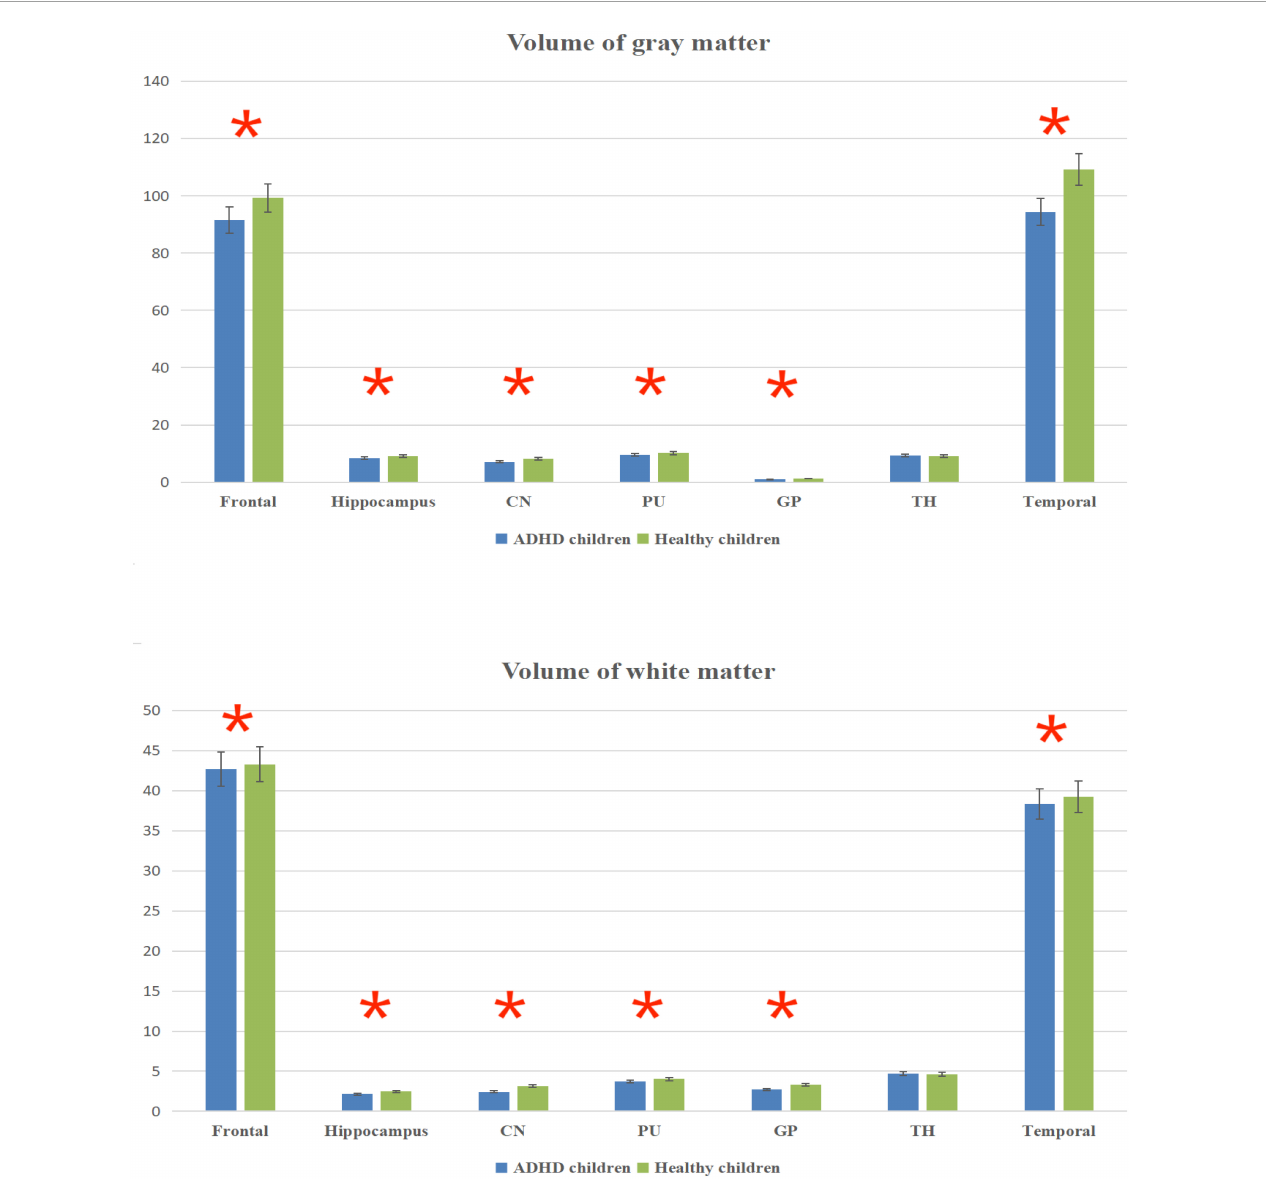
FIGURE3 Volume column chart of gray matter and white matter. *Statistical significance at the level of